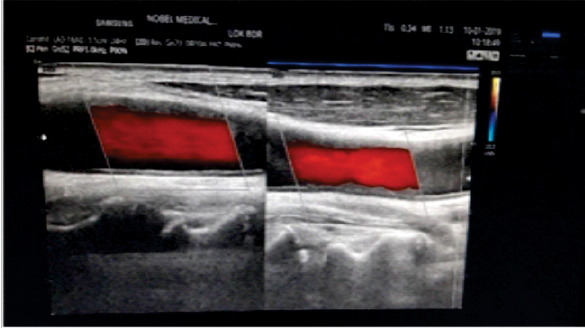
Figure 7: Risk factors with percentage stenosis